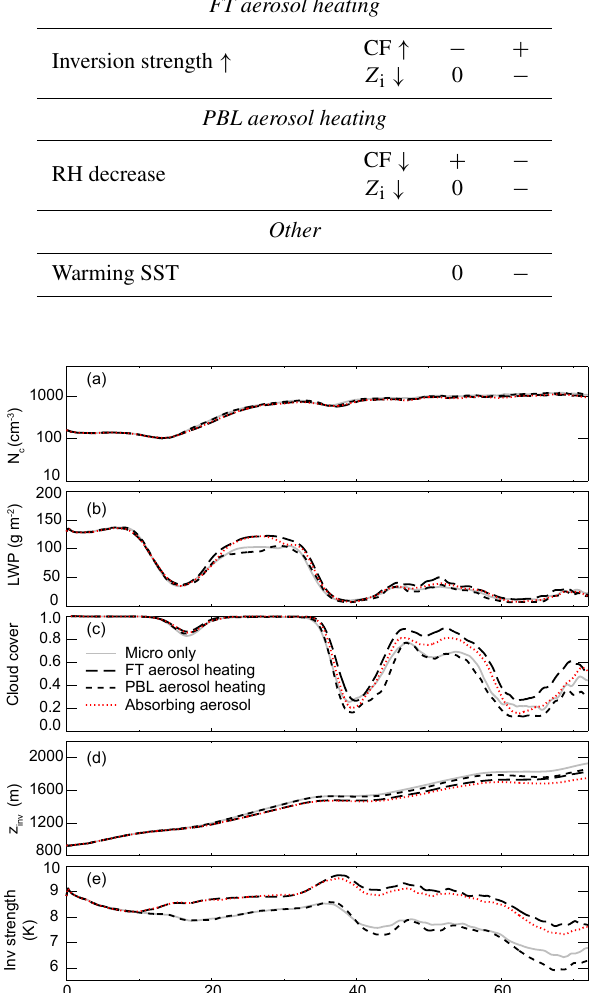
Figure 5. As in Fig. 2. All cases include initially overlying absorb- ing aerosol and allow them to act as CCN. For gray solid line the aerosol does not affect radiation. For long and short dashed lines, the aerosol affects radiation only in the free troposphere (FT) and planetary boundary layer (PBL), respectively. For red dotted line there are no restrictions on aerosol affecting radiation, as in Fig. 2.